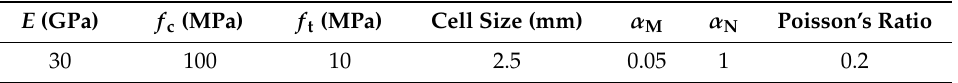
Table 5. Values of input parameters in the numerical analyses about the tensile splitting test.